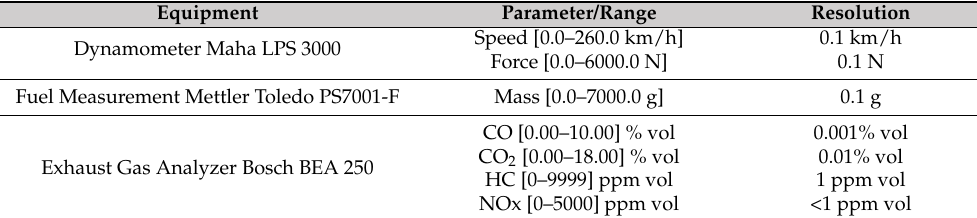
Figure 1. Assembly diagram of the equipment involved in the tests. Table 1. Main characteristics of the measurement equipment of the laboratory